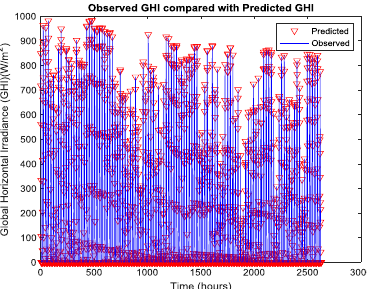
Fig. 2. Input GHI data samples.